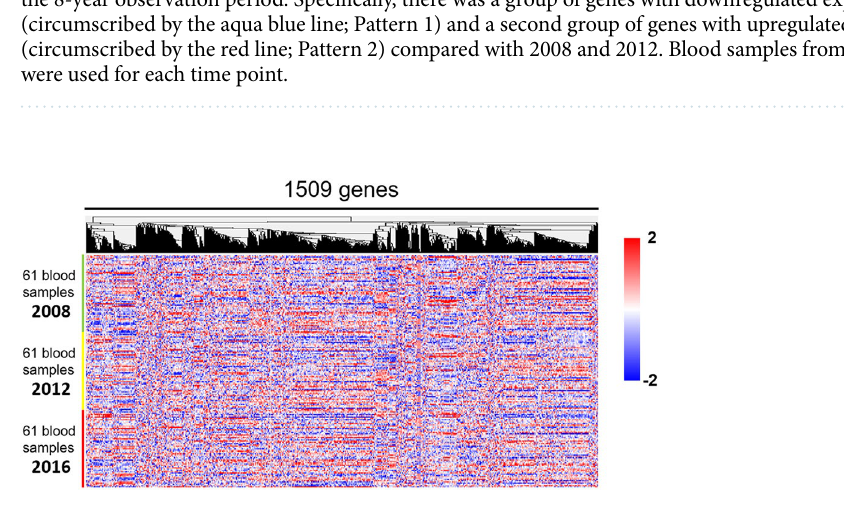
Figure 2. Identification of 1509 non-differentially expressed genes between the years 2008, 2012, and 2016. Among the 10,590 pre-filtered genes, the expression of 1,509 genes did not change over time and they were defined as the most representative stably expressed genes (Pattern 0; F-test parametric p- value >